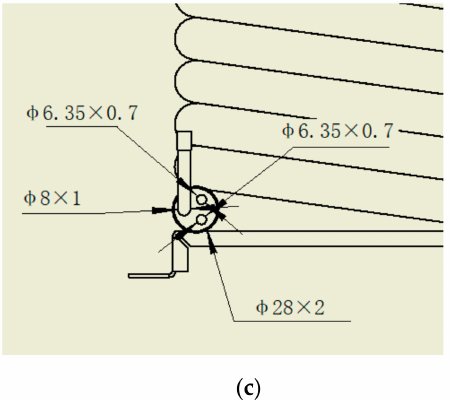
Figure 1. ( a ) The sketch map of the dual CO 2 system; ( b ) the p - h diagram of the dual CO 2 system; ( c ) the sketch map of the dual gas